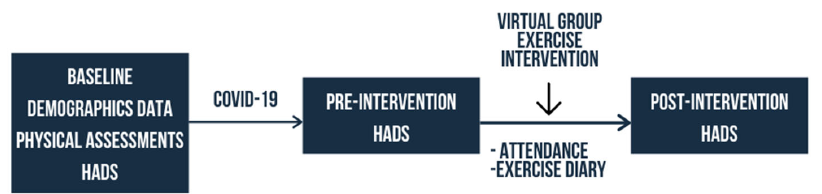
Figure 2. Study Figure 2. Study framework. The virtual exercise class started with deep breathing and correction of posture. Exercises for neck, chest, shoulder, upper back, lower back, abdomen, thigh and ankle rotation were conducted in the seated position. Lower back and abdominal strengthening exercise were conducted in the supine position. Hip abduction and adduction, calf and ankle exercises were then conducted in the standing position. Coordination and fine motor training included face muscles exercise, fingers movement exercise, alternating hand exercise, and towel toe curl. Additionally, ankle alphabet exercise were performed to improve flexibility. The sessions ended with deep breathing and a reminder to fill ‐ in their exercise diary. The range of exercises explained above were performed alternately and gradually increments in repetitions which were limited largely by time availability. Participants who were unable to attend the virtual group exercise were encouraged to conduct individual home ‐ based exercises guided by an electronic exercise booklet and video. The “PISA exercises for older adults” video and booklet had been developed in 2016 as part of a public engagement activity of the original research program. Those who did not participate in virtual exercises were reminded to exercise daily and to fill ‐ in their diary, either via the WhatsApp TM group chat or private messages. 2.4.1. Adherence Adherence to both virtual groups and home ‐ based individual exercises were measured using self ‐ administered exercise diaries with daily entries. This collected information on which days of the week the participant had conducted their exercises. Exercise diaries were either sent out electronically or through couriers as per participant preference. In addition, attendances were taken for each virtual group exercise sessions as an additional measure of adherence. 2.5. Data Analysis Data analysis was performed using the IBM SPSS Statistics 21 and a p value of less than 05 was considered statistically significant. Descriptive statistics were presented in frequencies with percentages and mean with standard deviation. Mixed between ‐ within subject ANOVA was used to investigate the effect of time (baseline, pre and post intervention), intervention and interactions between time and groups. Missing data were analyzed using Little’s MCAR test and multiple imputation performed. 3. Results 3.1. Recruitment Two hundred and fifty ‐ one PISA participants were approached via the social media messaging application WhatsApp TM , of whom 45 agreed to participate with two dropouts before the exercise program started (Figure 1). A 23% drop ‐ out was recorded for the online post ‐ intervention survey after two reminders sent out via WhatsApp TM in group and personal text messages.